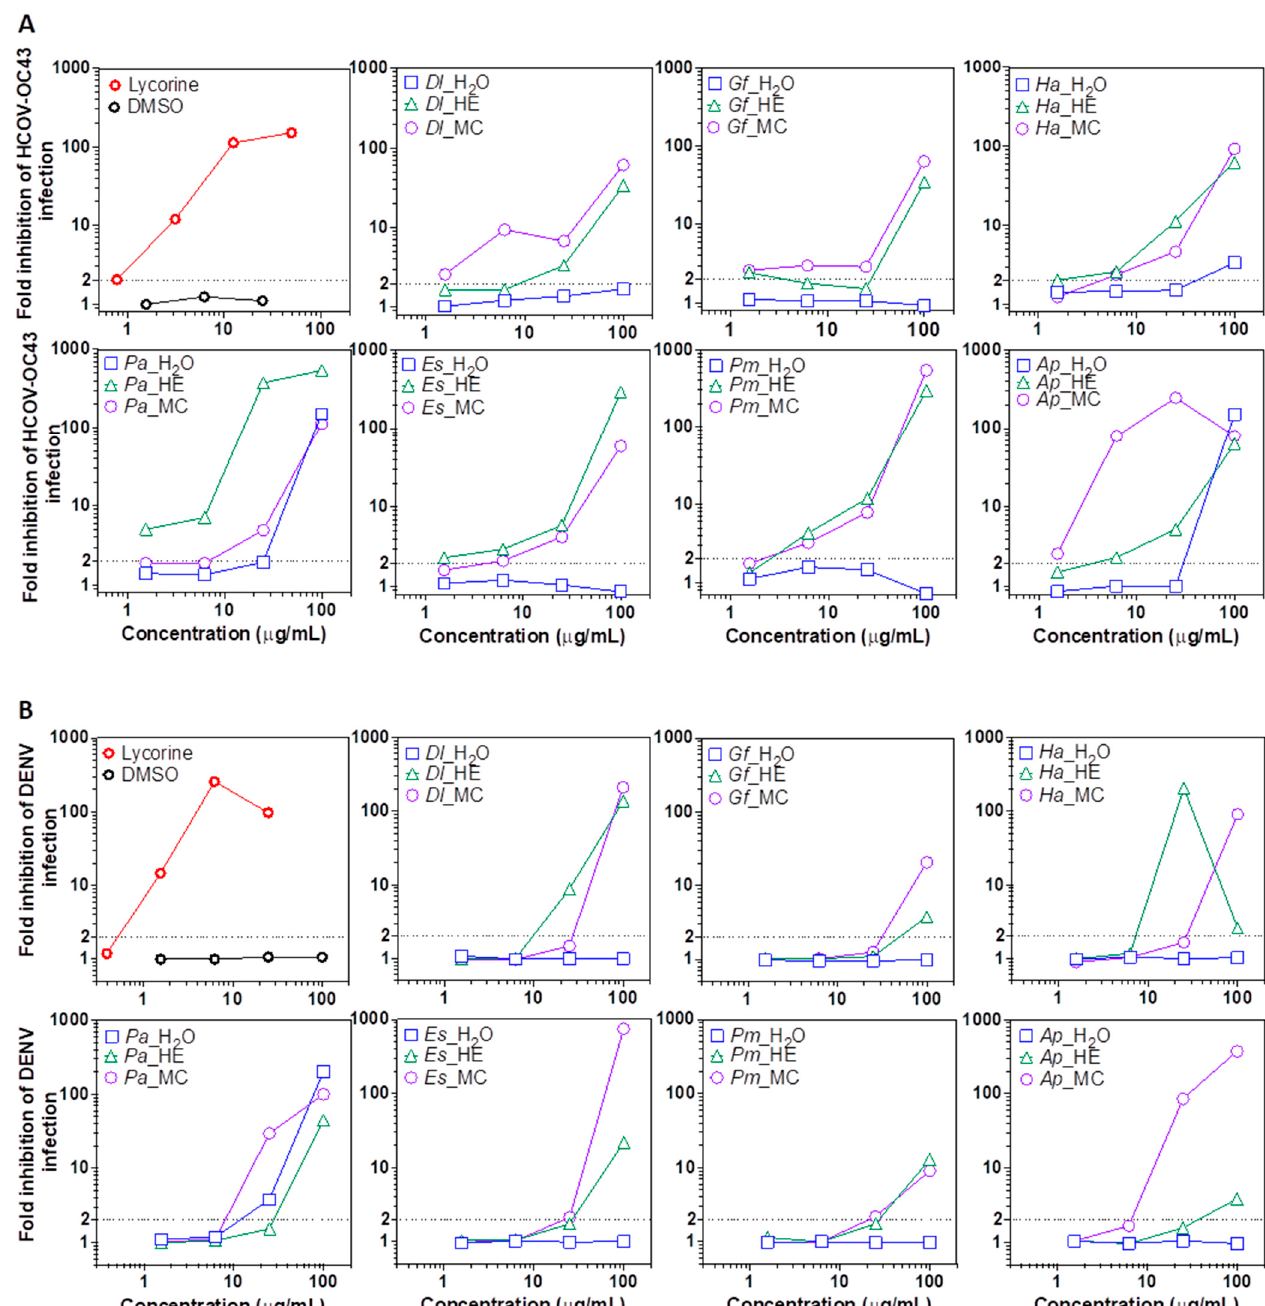
Figure 4. Antiviral activity of plant extract fractions. ( A ) Anti-betacoronavirus 1 (HCOV-OC43, human coronavirus OC43). ( B ) Anti-flavivirus (dengue virus, DENV). Results are expressed as fold inhibition calculated as the ratio of infection (% GFP+ cells) for solvent-treated cells over extract- treated cells. The % of infected (GFP+ cells) was measured by flow cytometry. Dl : Daucus lopadusanus ; Gf : Glaucium flavum ; Ha : Hypericum aegyptum ; Pa : Periploca angustifolia ; Es : Echinops spinosus ; Pm : Prasium majus ; Ap : Atriplex halimus ; H 2 O: H 2 O phase ; HE: hexane extract; MC: : CH 2 Cl 2 extract; MTT: tetrazolium salt.